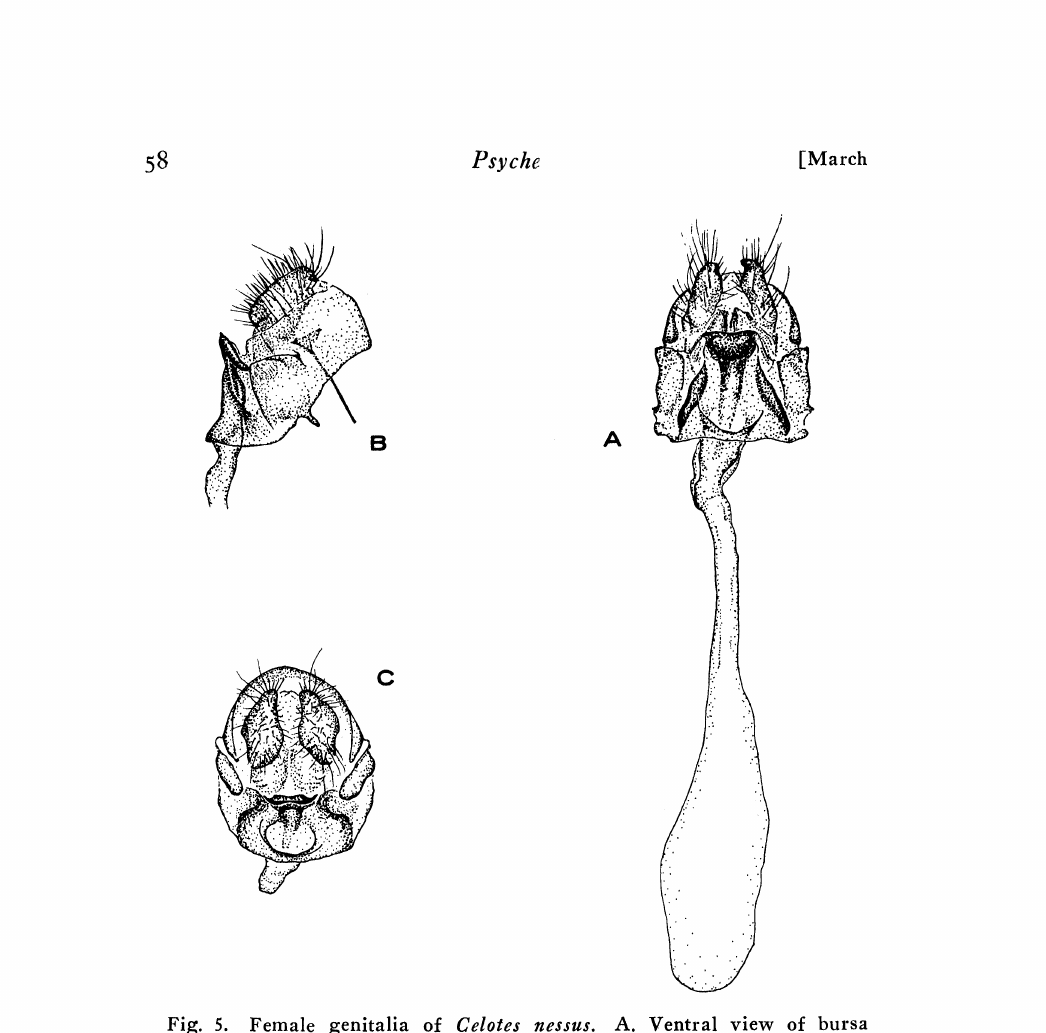
Fig. 5. Female genitalia of Celotes nessus. A. Ventral view of bursa eopulatrix, sterigma, and ovipositor lobes. B. Right lateral view. C. Ven- troposterior view. [Drawn from female from Austin, Travis County, Texas, IV-18-1967 (J. M.